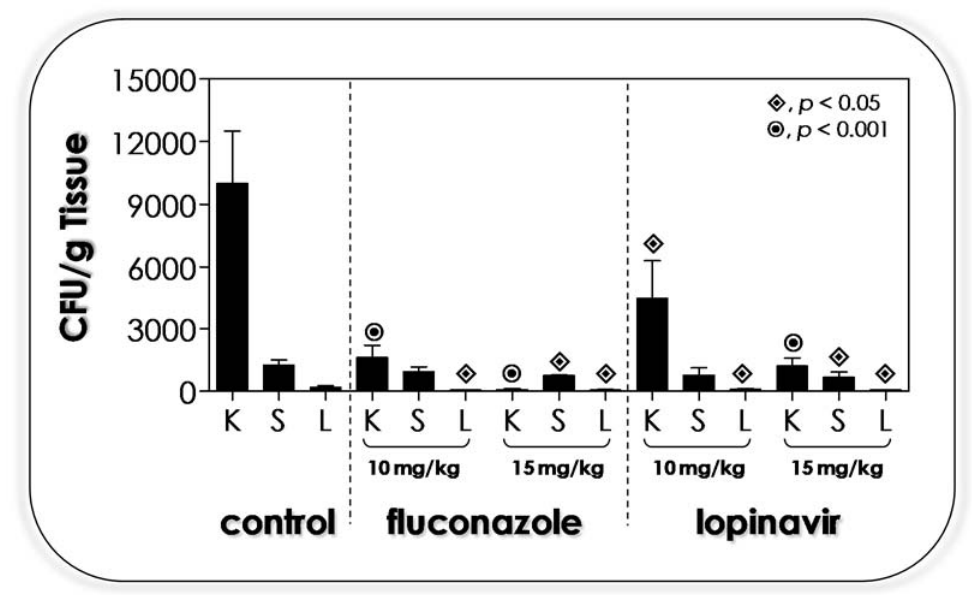
Figure 10. Effects of lopinavir on the in vivo infection of immunocompetent mice with C. albicans . Six female BALB/c mice per group were intravenously infected with 10 5 yeasts. After 1 h, the animals were treated with PBS (control group), fluconazole (at both 10 and 15 mg/mL) and lopinavir (at both 10 and 15 mg/mL). To evaluate the fungal burden, after 5 days post-infection, the animals were anaesthetized and euthanized, and then the kidneys (K), spleen (S) and liver (L) of the mice were dissected, weighed, homogenized in PBS and inoculated in BHI medium to evaluate the number of CFUs. The values represent the mean ± standard deviation of three independent experiments performed in triplicate. The symbols indicate the experimental systems considered statistically significant from the control (ANOVA followed by Tukey-Kramer post-test).